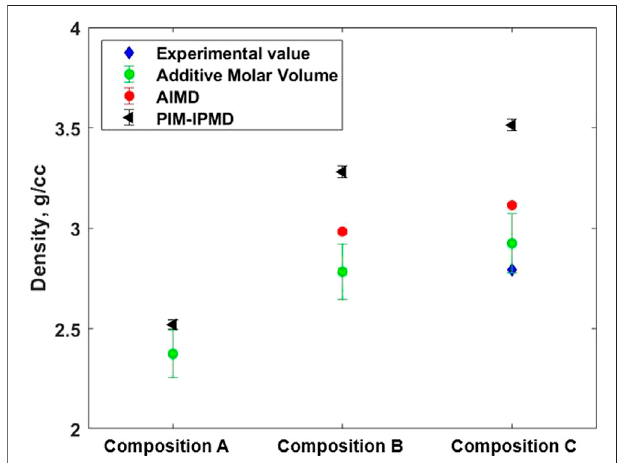
FIGURE 9 | Density prediction